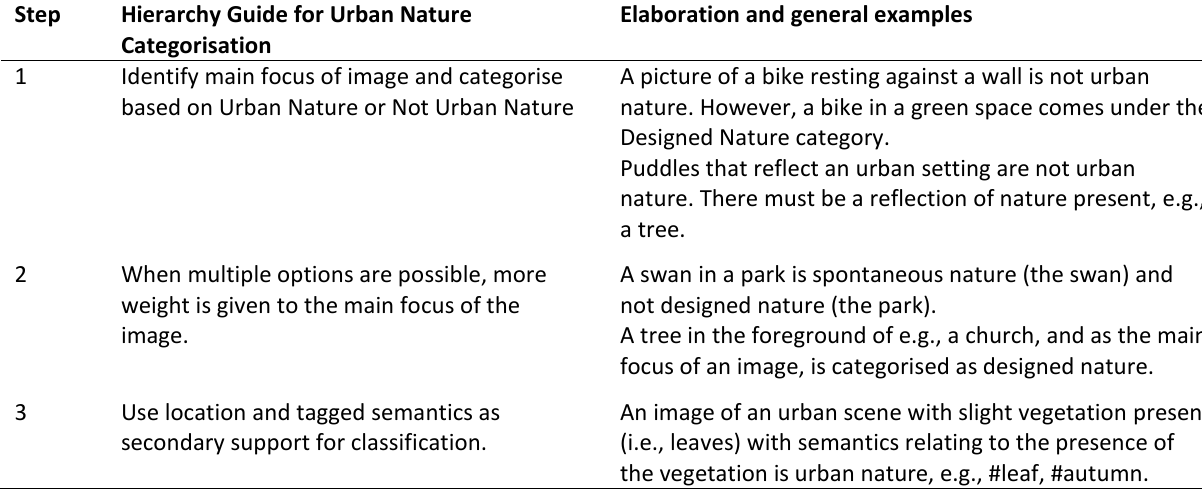
Table 2. A three-step hierarchical how-to guide was produced to clarify the categorisation process. Step